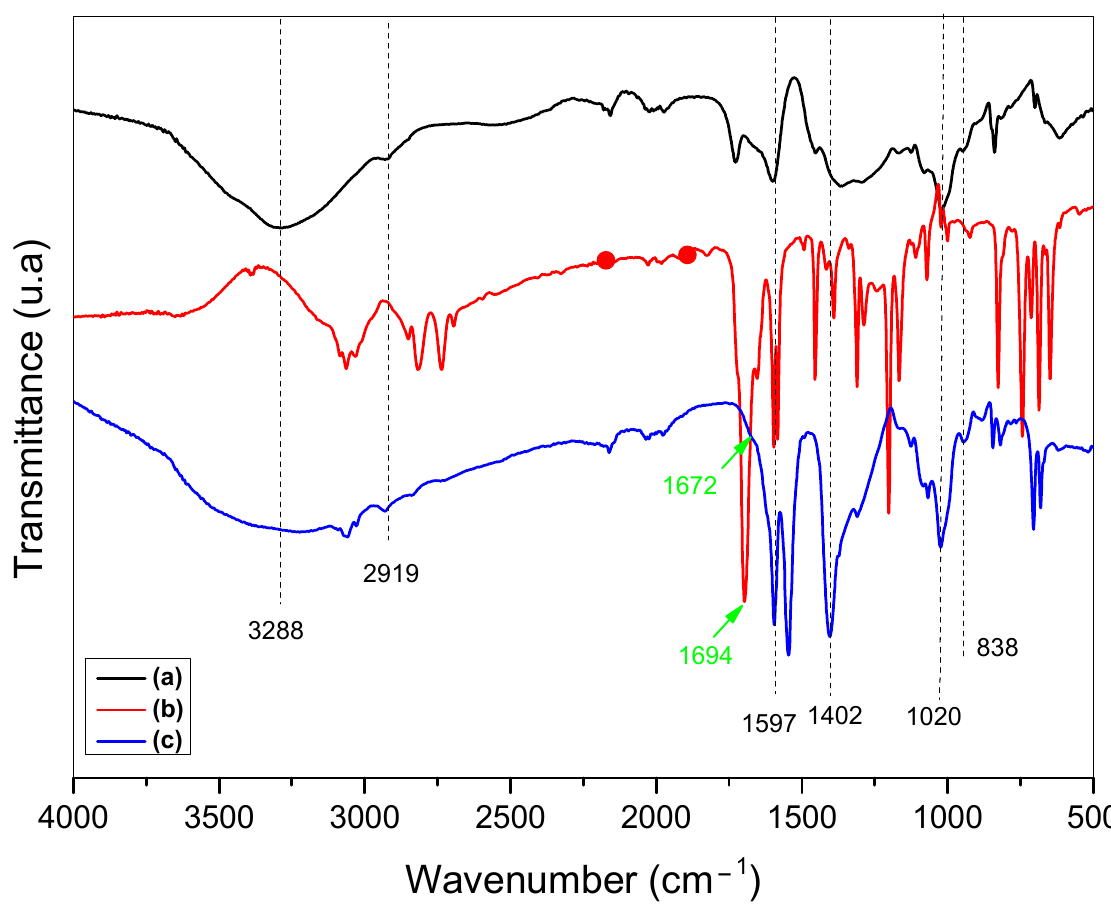
Figure 4. FTIR spectra ( a ) SA from Sargassum muticum , ( b ) benzaldehyde, and ( c ) SA after the adsorption of benzaldehyde.